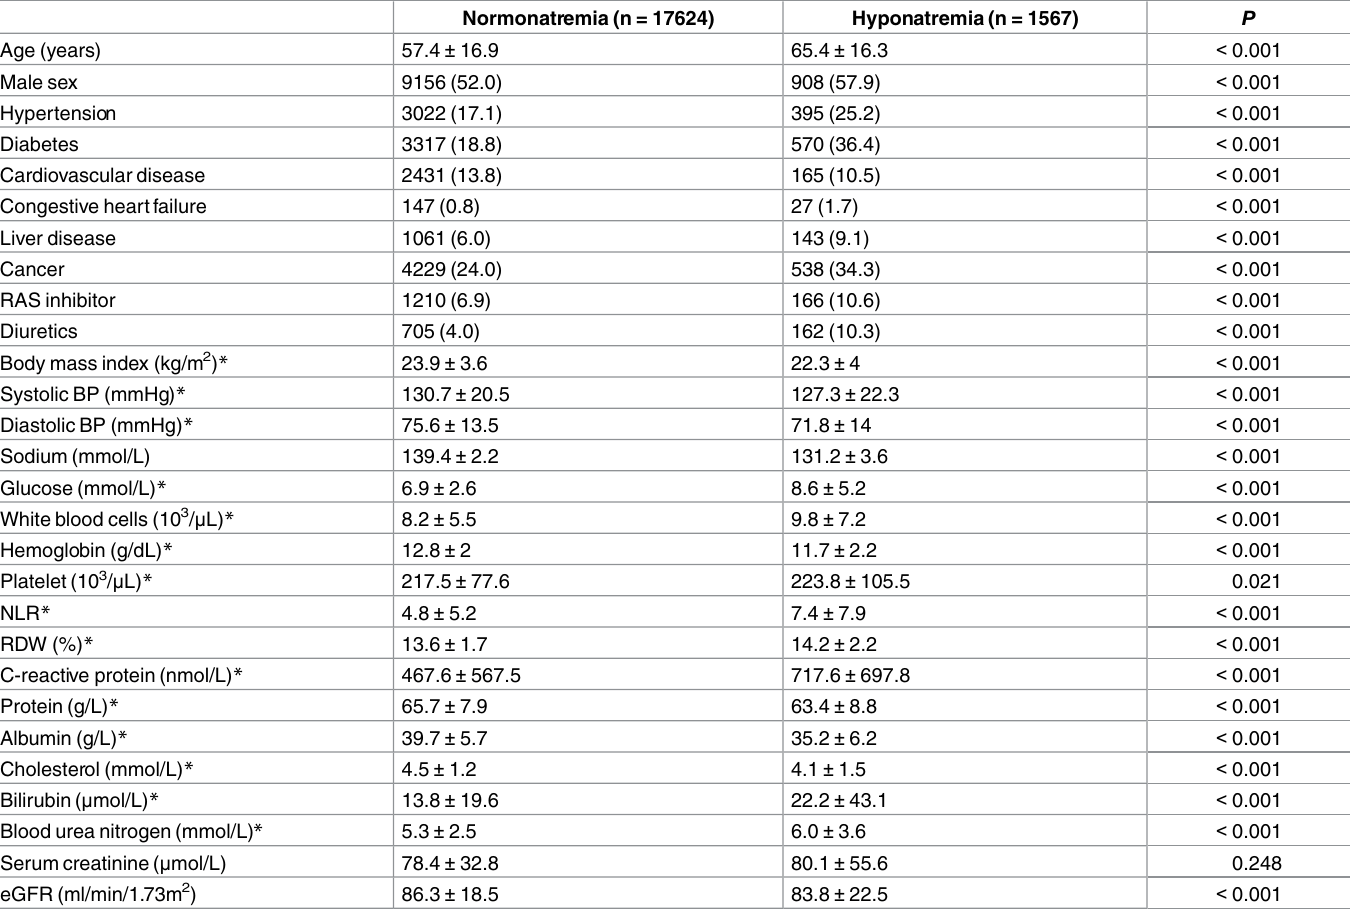
Table 1. Baselinecharacteristicsof